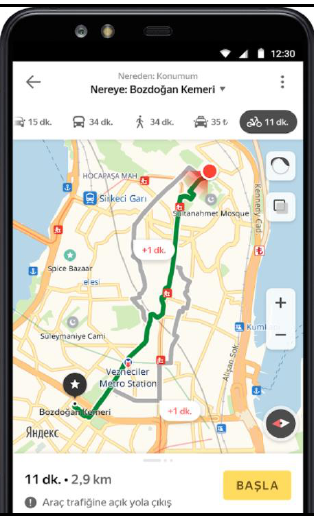
Figure 16 . Creating a bike route with Yandex Maps.